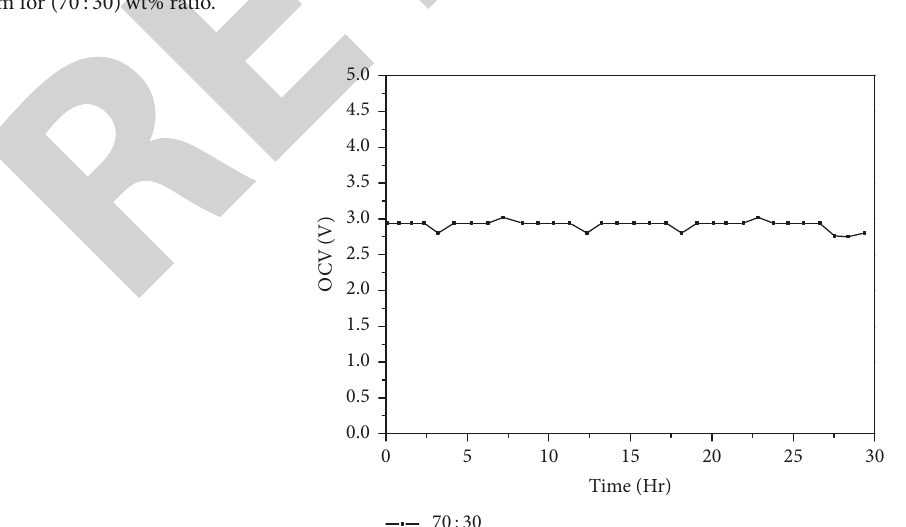
Figure 12: OCV of solid polymer electrolyte film for (70: 30)wt%